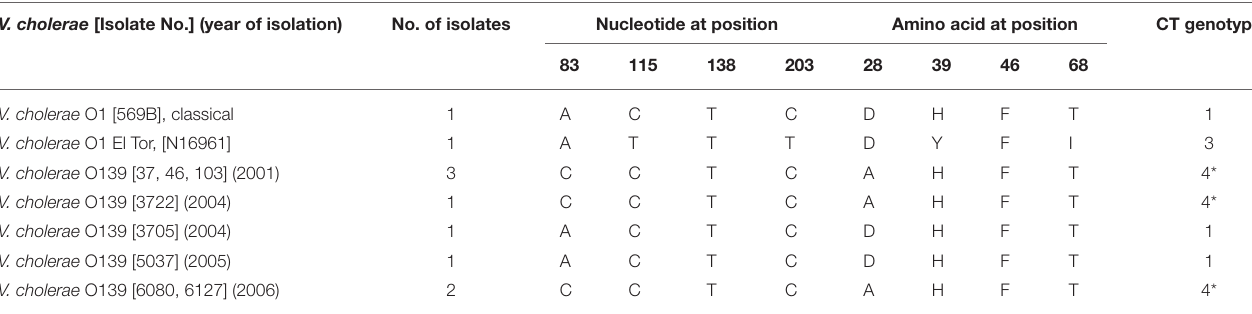
TABLE 2 | CT genotypes of V. cholerae O139 based on DNA sequences of ctxB. V. cholerae [Isolate No.] (year of